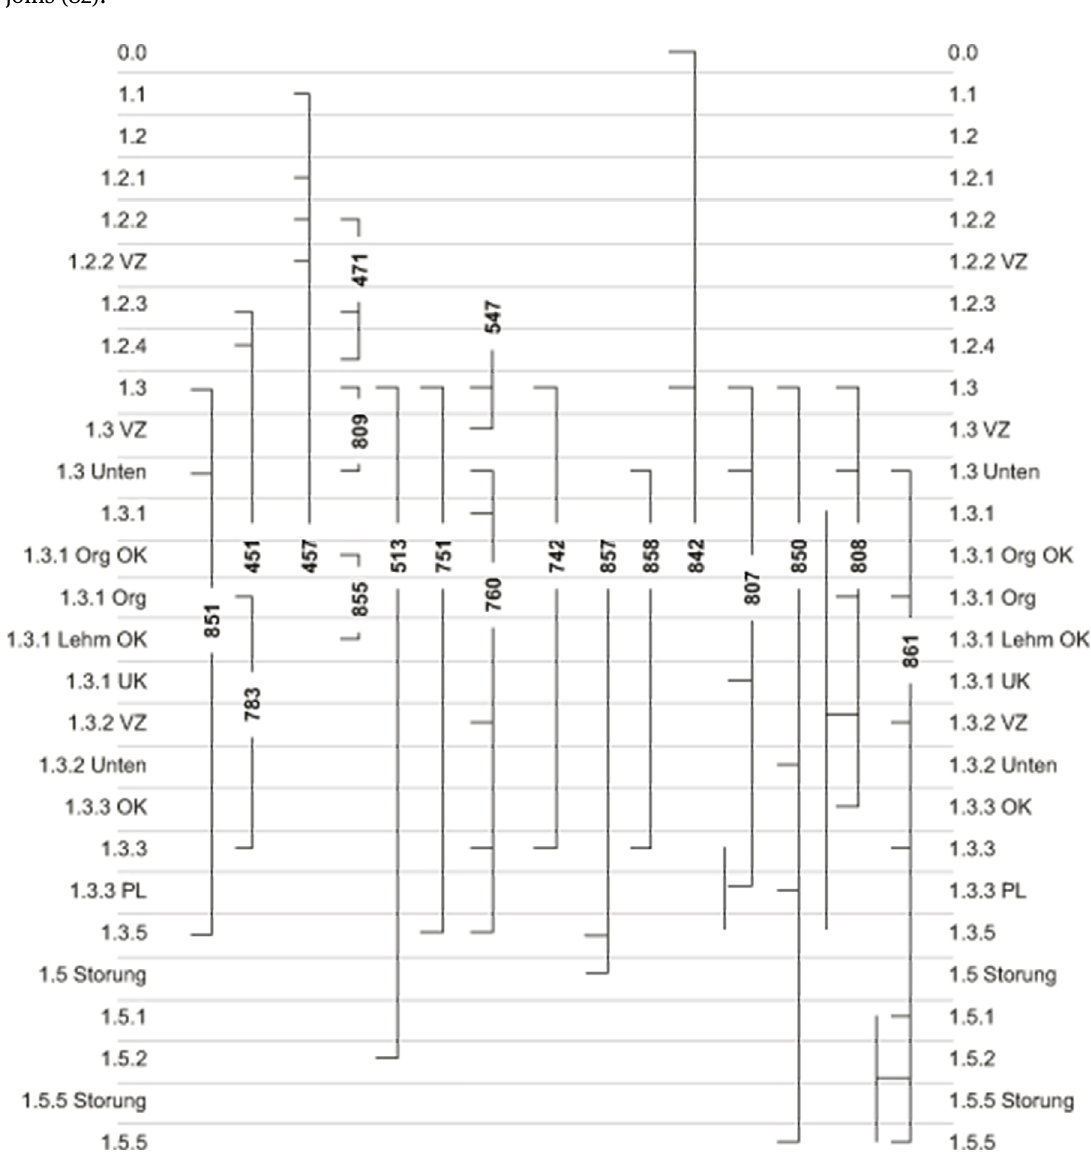
Figure 7. Inter-layer ceramic refits from occupation phase D at Zürich-Alpenquai (data from Künzler Wagner